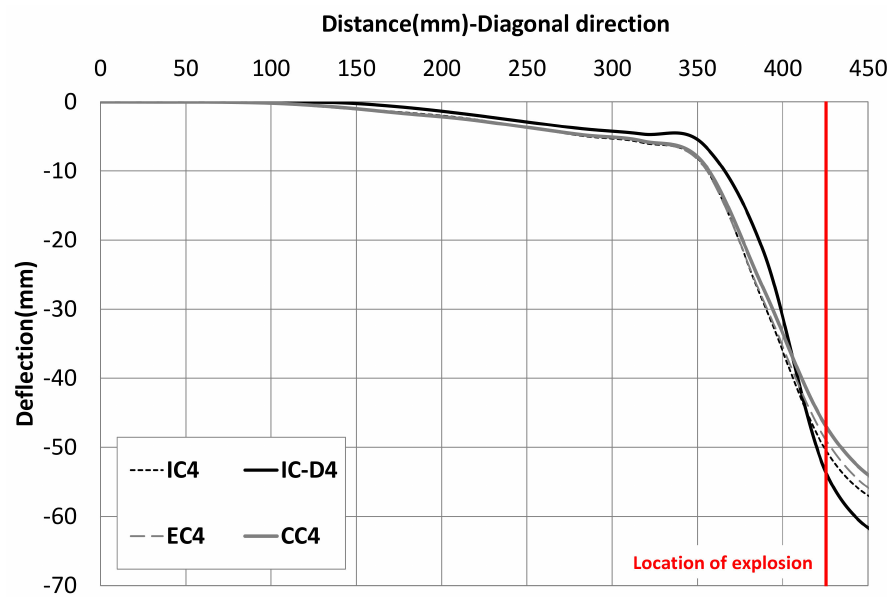
Figure 6. Slab deflection of specimens with TNT 4 kg.